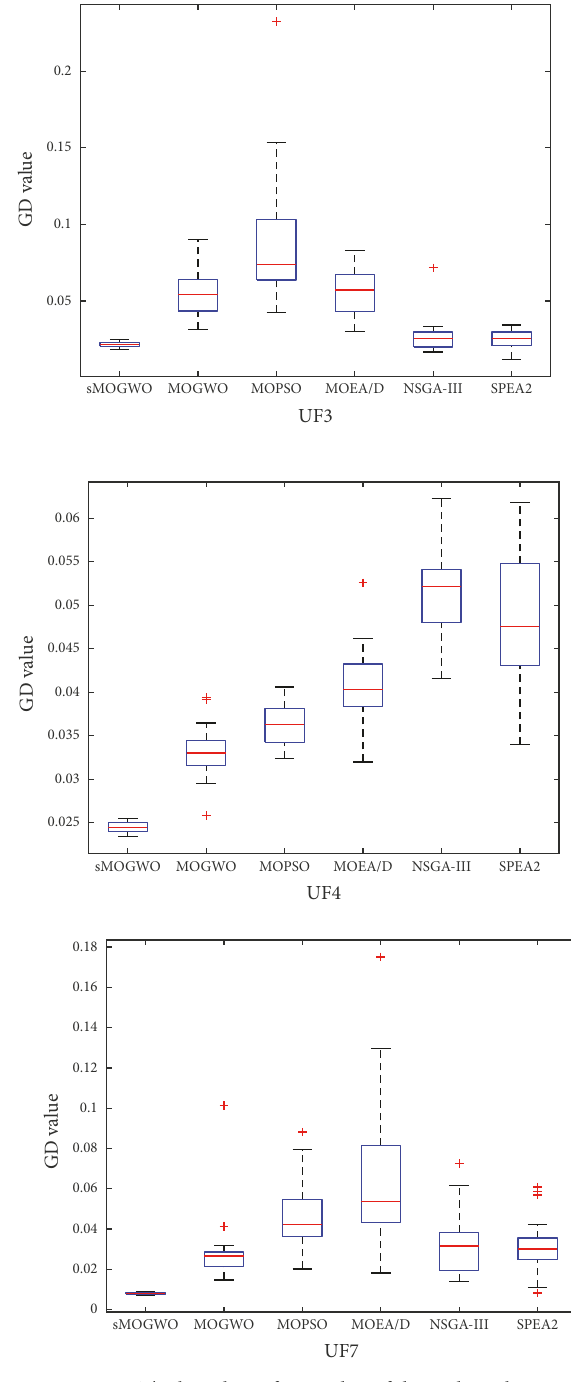
Figure 5: The boxplots of GD value of three